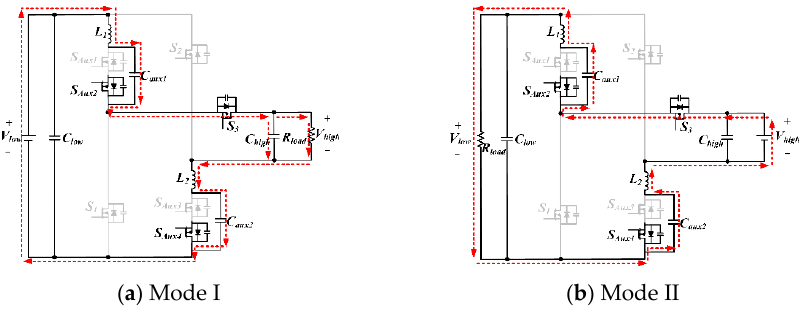
Figure 11. The current flow path of transition from step-up mode to step-down mode.